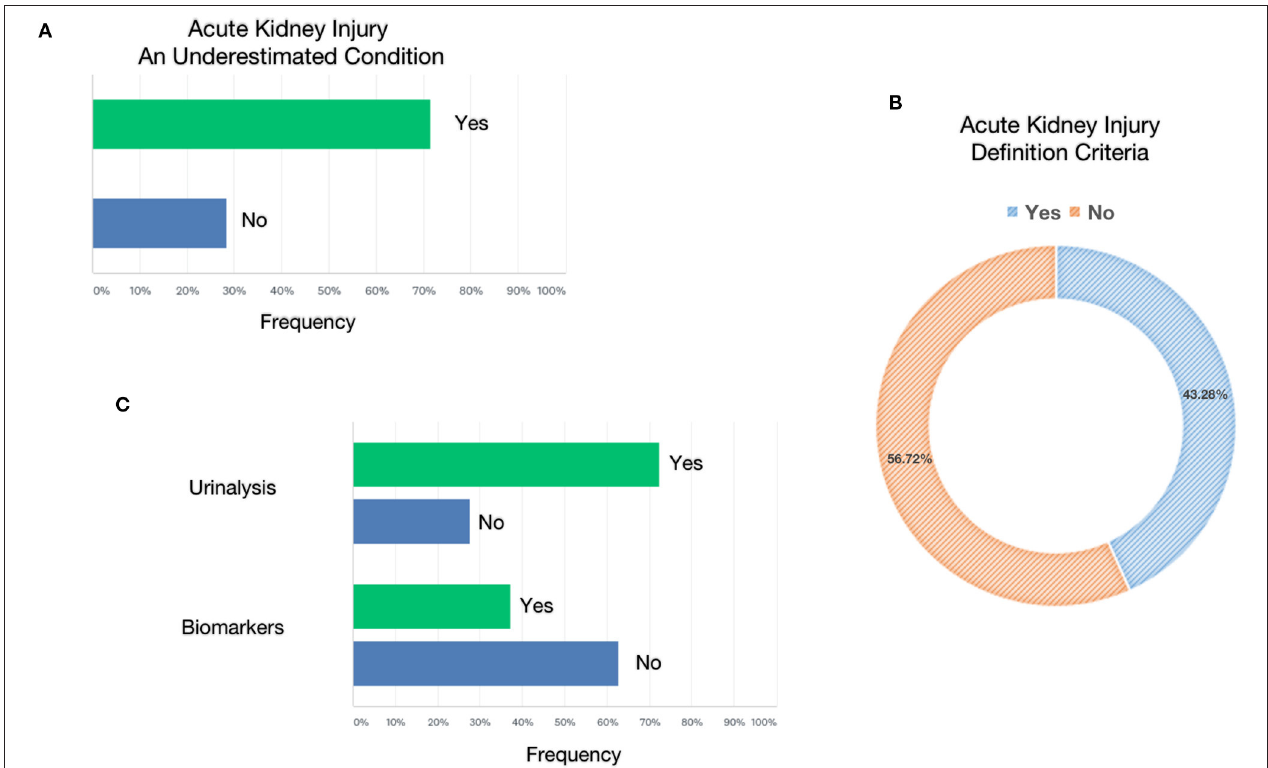
FIGURE 4 | Extracorporeal blood purification therapies . (A) Reported the conditions considered to start extracorporeal blood purification therapies. (B) Reported the membranes or modalities used in patients with COVID-19. (C) Reported the likelihood to test interleukin-6 (IL-6) in enrolled centers.